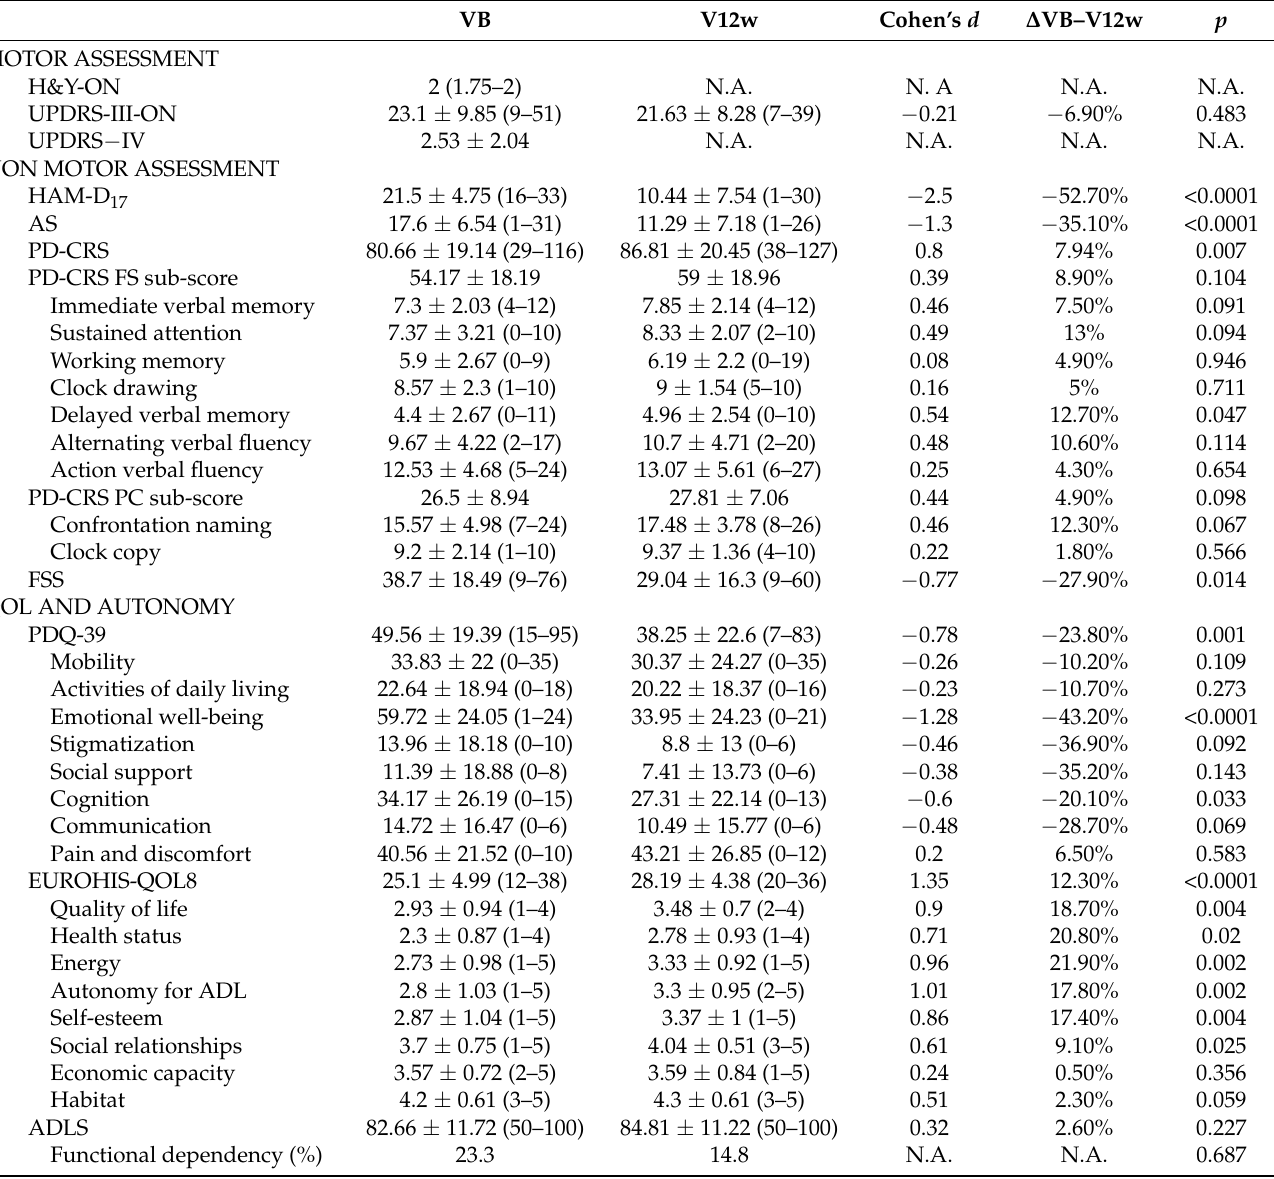
Table 2. Change in the HAM-D 17 total score and other scales of the study from VB (baseline; N = 30) to V12w (12 weeks ± 14 days; N =